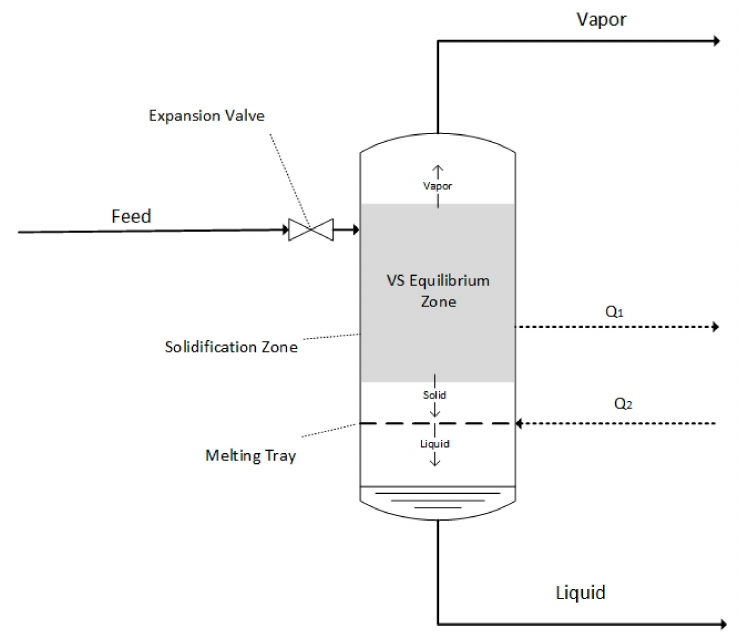
Figure 1. Schematic diagram for the suggested SV separation unit. The feed, which should initially be in liquid phase, is throttled using the expansion valve. Ideally, the throttling process is performed adiabatically, but subsequent cooling (Q 1 ) might be required to either ensure that its pressure and temperature drop to a condition that corresponds to the SVE zone (where CH 4 remains in the vapor phase and only CO 2 and H 2 S solidify [22]) or enhance the separation of acid gases. Figure 2 further explains this process; the conditions of the feed stream (point “1”) are transformed to reach point “2”, at which the mixture enters the solidification zone and the separation of acid gases into a solid phase is achieved. The formed solids (in the SVE zone) descend due to their higher densities, reaching the melting tray, which is supplied with sufficient heat (Q 2 ) to melt the solids into a liquid stream. The formed liquid stream (consisting of CO 2 and H 2 S) can be collected at the bottom of the unit, whereas high-purity methane gas is collected at the top of the unit.